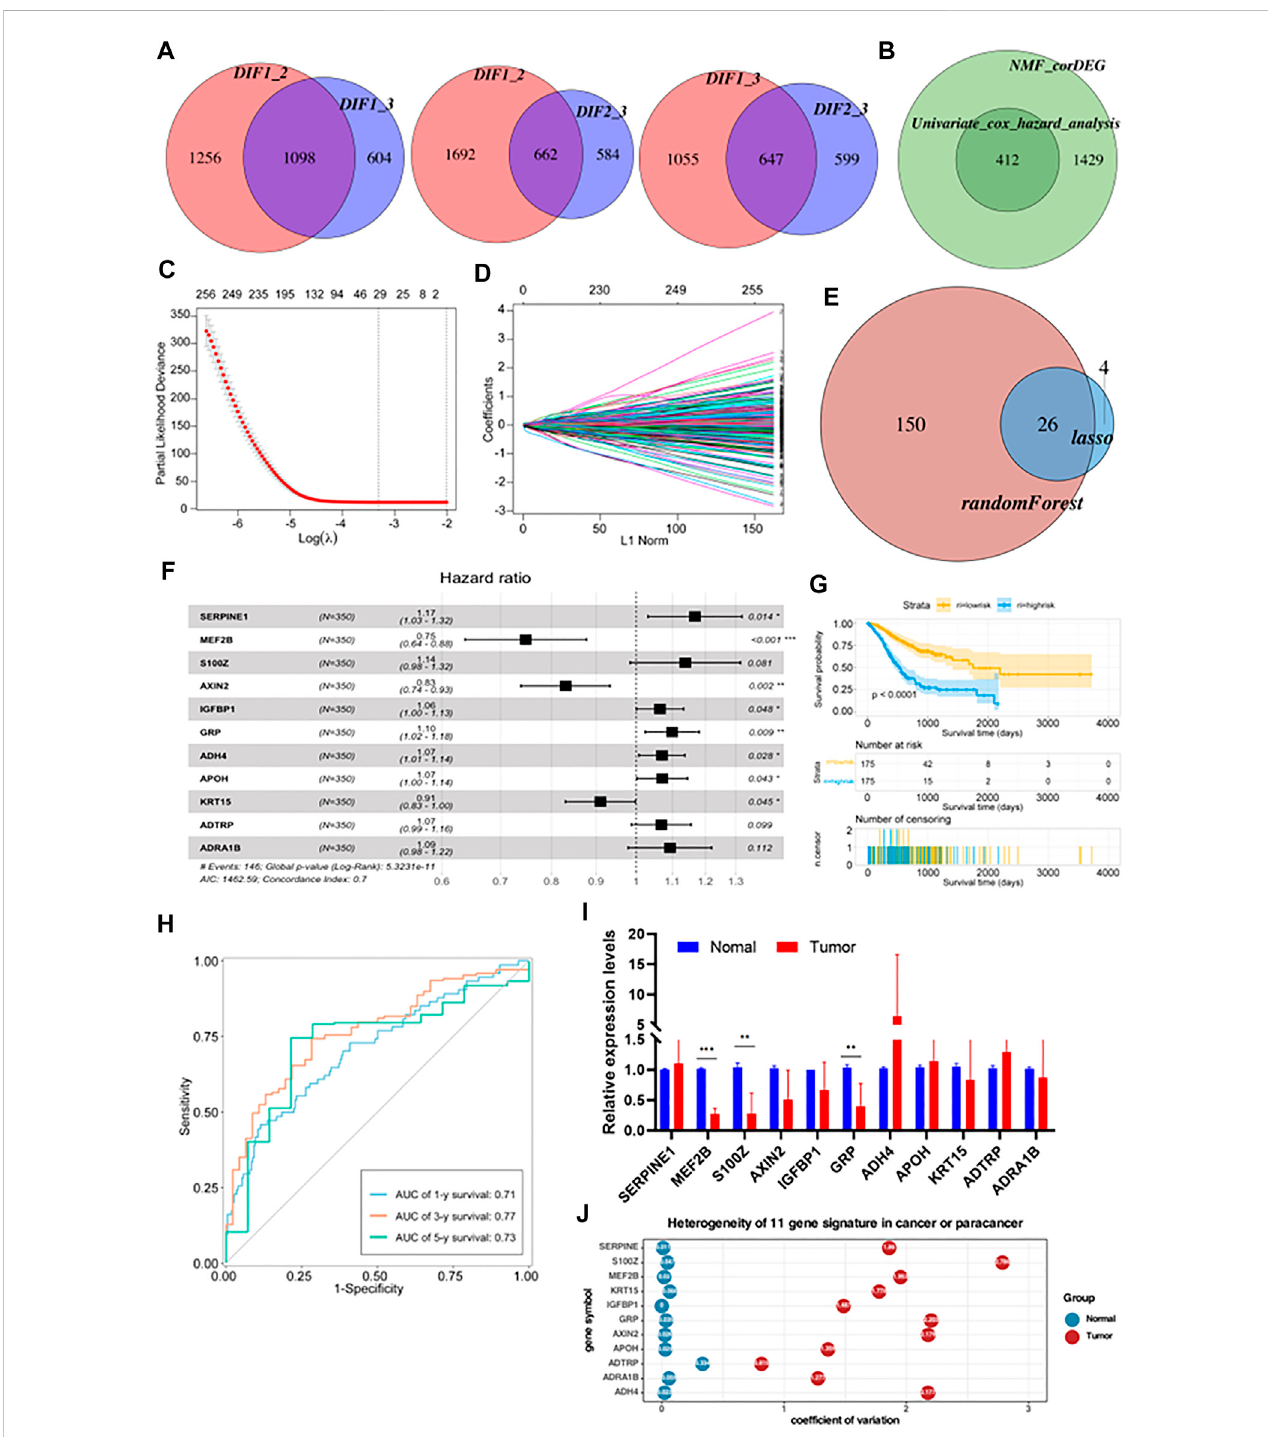
FIGURE 4 Construction of a prognostic risk model based on metabolism-related genes (A) The differential enrichment score of gene sets was calculated between each of the two subgroups and intersected them. Subtype 1, subtype 2 and subtype 3 had 1,098, 662 and 647 distinct gene sets, respectively. (B) Batch Cox regression analyses screening for prognosis-related differential genes. (C) The dotted vertical lines represent the optimal values of λ . The top x -axis has the numbers of gene sets, whereas the lower x -axis revealed the log ( λ ). (D) Least absolute shrinkage and selection operator (LASSO) coef fi cient pro fi les ( y -axis) of the gene sets and the optimal penalization coef fi cient ( λ ) via 10-fold cross-validation based on partial likelihood deviance. (E) Take the intersecting genes after lasso and random-forest screening. (F) Constructing a stepwise Cox proportional hazards model. (G) Kaplan – Meier OS curves with difference detectionbylog-ranktestforpatientsfromthetrainingdatasets. (H) ROCcurveanalysesbasedonthe11genesignature. (I) RelativeexpressionlevelsofmRNA for 11 gene signature. (J) Coef fi cient of variation of 11 gene signature in cancer and paracancerous